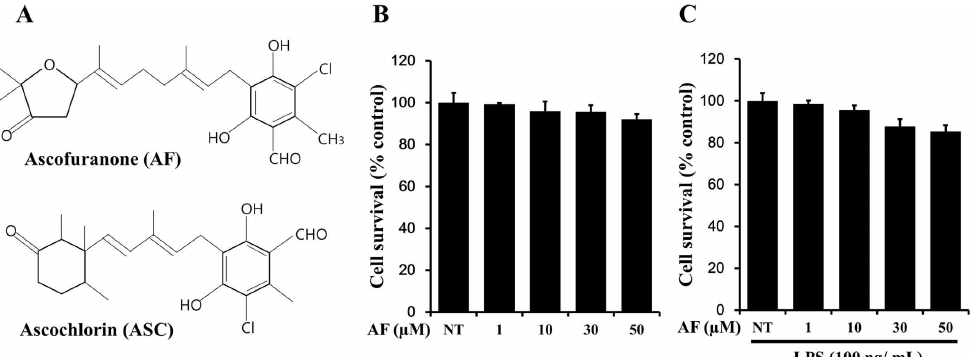
Fig 1. Chemical structure and effectsof AF on cell viability in RAW 264.7 macrophage cells. ( A) Chemical structure of AF. (B), (C) Cells (1 × 10 4 cell/well) were treated with the indicatedconcentrations of AF in the absenceor presence of LPS for 24 h, and cellularviabilitywas measuredby the MTT assay. The data shown are representative of three independentexperimentsand indicate the mean ± SEM. NT indicates“no